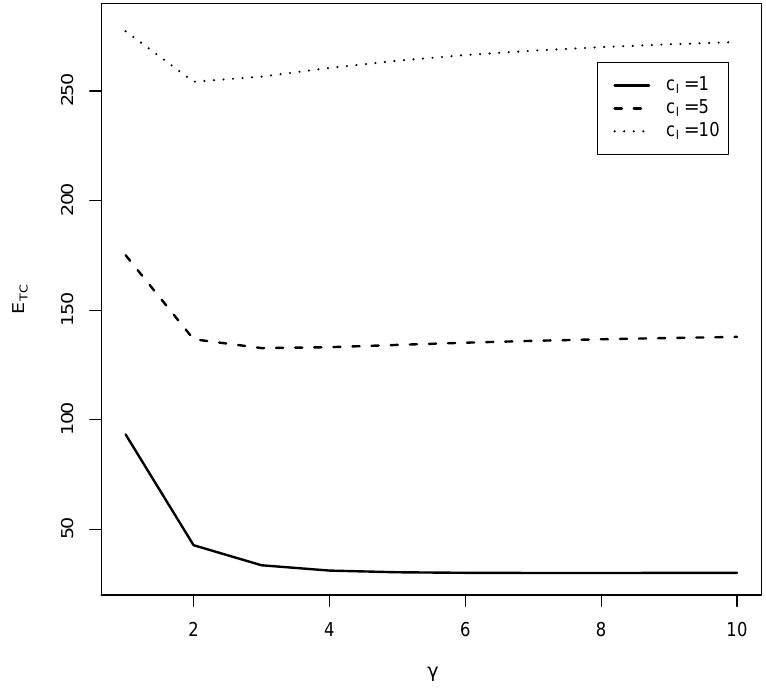
Figure 8. Total cost E TC versus γ = 1, . . . ,10 for various c I = 1,5,10; the parameters are S = 50, s = 5, l 2 = 10, µ 1 = 7, µ 2 = 15, MMAP arrival process parameters given in